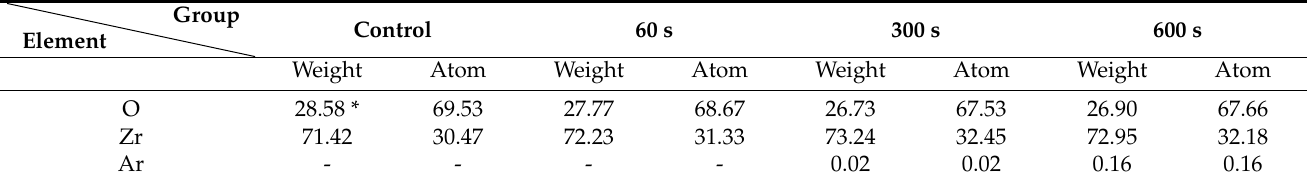
Table 1. Elemental value following plasma treatment.